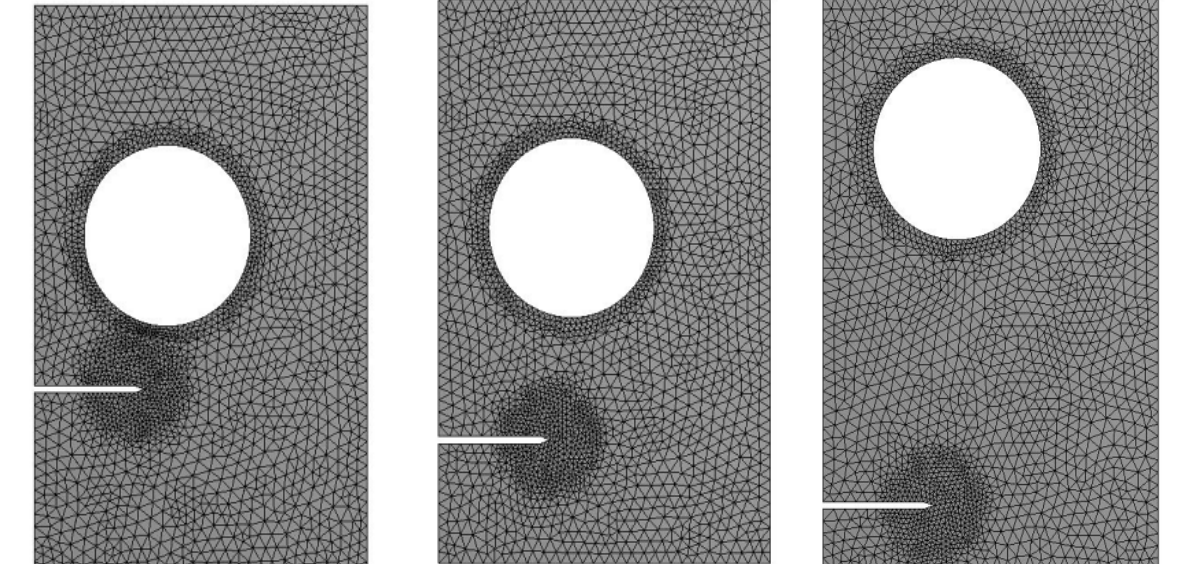
Figure 18. Initial adaptive mesh for the three different configurations of plates with a circular hole and edge crack.